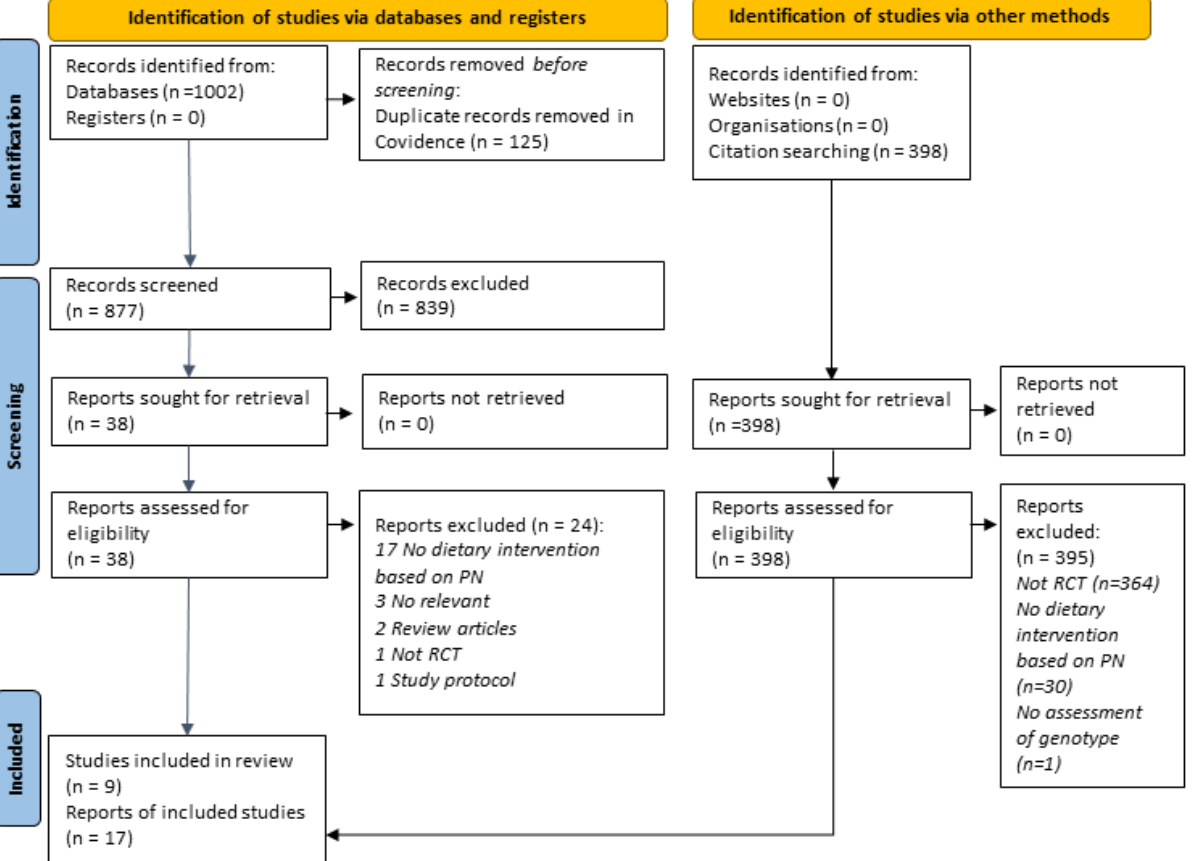
Figure 1. PRISMA 2020 flow chart showing the study selection process .